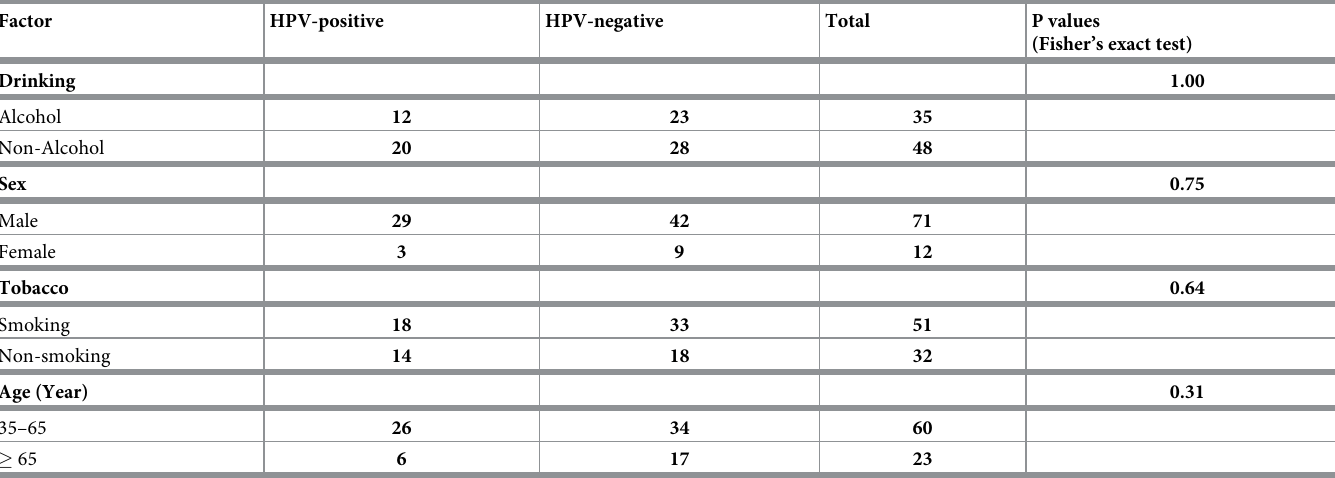
Table 3. Factors predictive of HPV positive